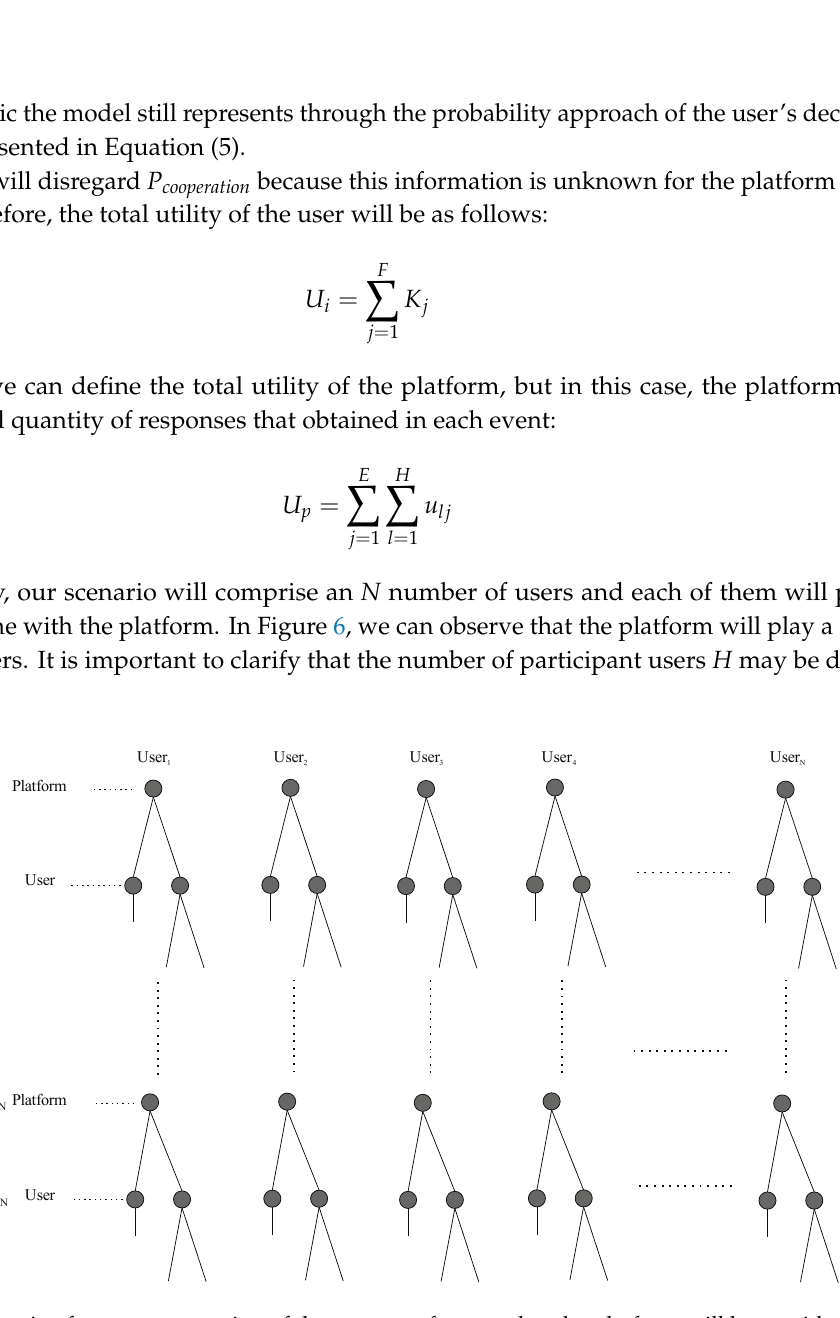
Figure 6. Extensive form representation of the amount of games that the platform will have with the different users.